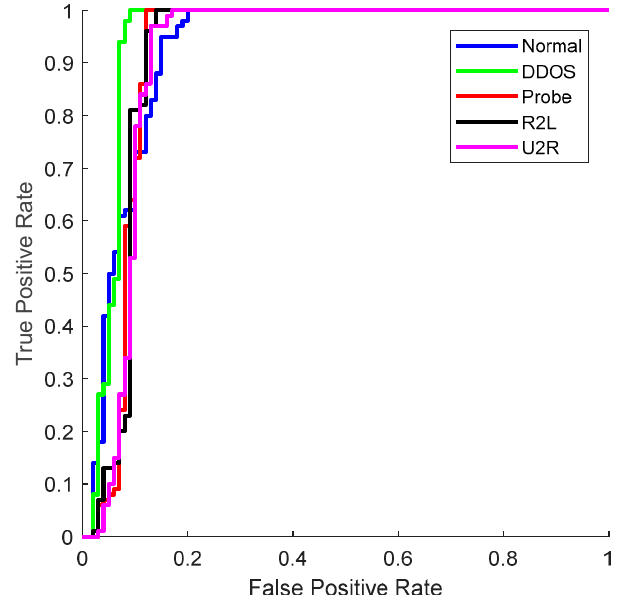
Figure 10. ROC for dataset 1.